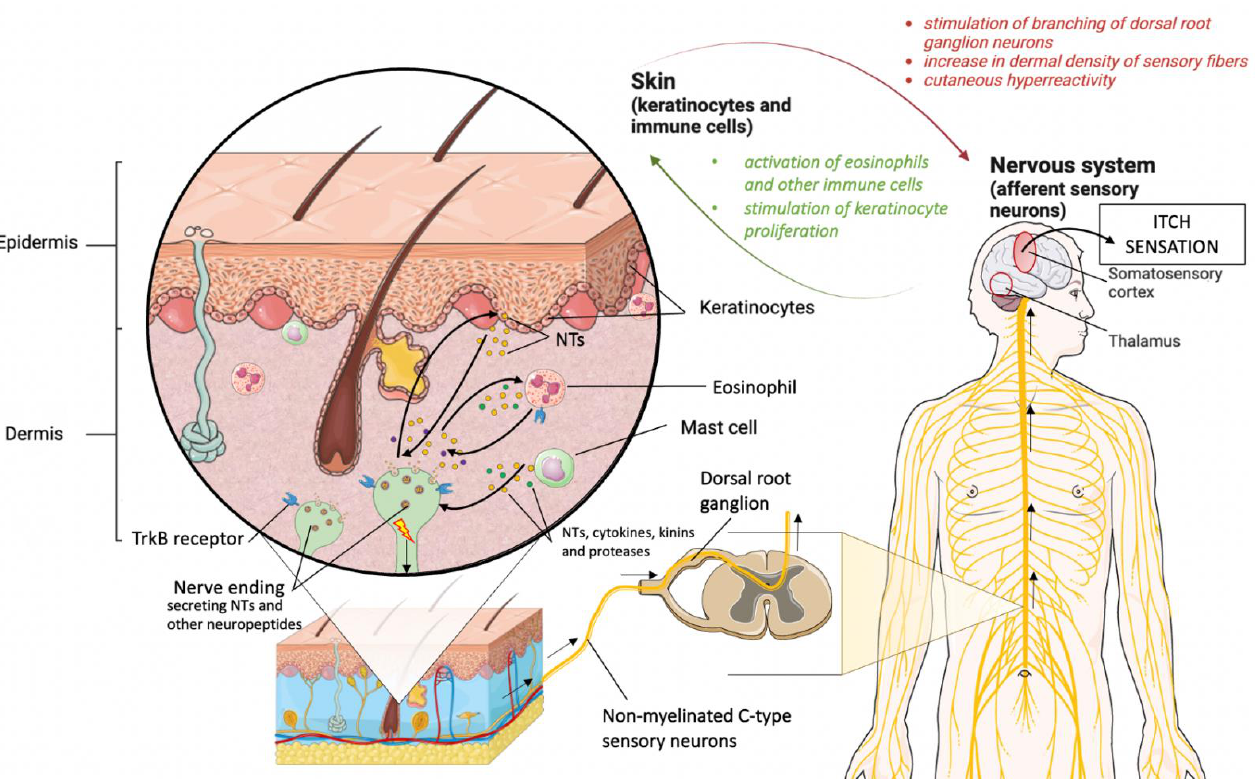
Figure 1. Possible pathomechanism of pruritus involving neurotrophins (NTs). Keratinocytes and skin immune cells produce NTs that activate receptors located on the cell membrane of nerve endings. The stimulated sensory neurons conduct impulses through the dorsal root ganglion to the somatosensory cortex, leading to an itching sensation. Simultaneously, the same molecules produced by non-neuronal skin cells lead also to an increase in skin density of sensory fibers and skin hyperreactivity. Moreover, nerve cells located in the skin have the ability to produce neuropeptides, including NTs, which in turn influence the proliferation of keratinocytes and the activation of immune cells, and further enhance mutual stimulation between neurons and non-neuronal skin cells. This figure was created using Servier Medical Art under a CC 3.0 license (https://smart.servier.com/, accessed on 23 September 2022) [27].